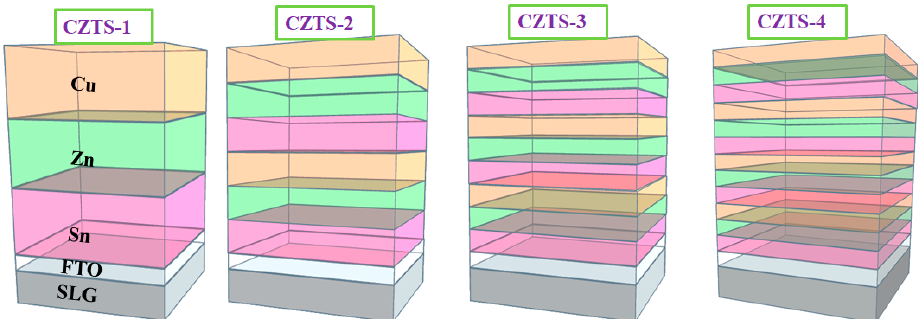
Figure 1. Schematic of precursor stacks.